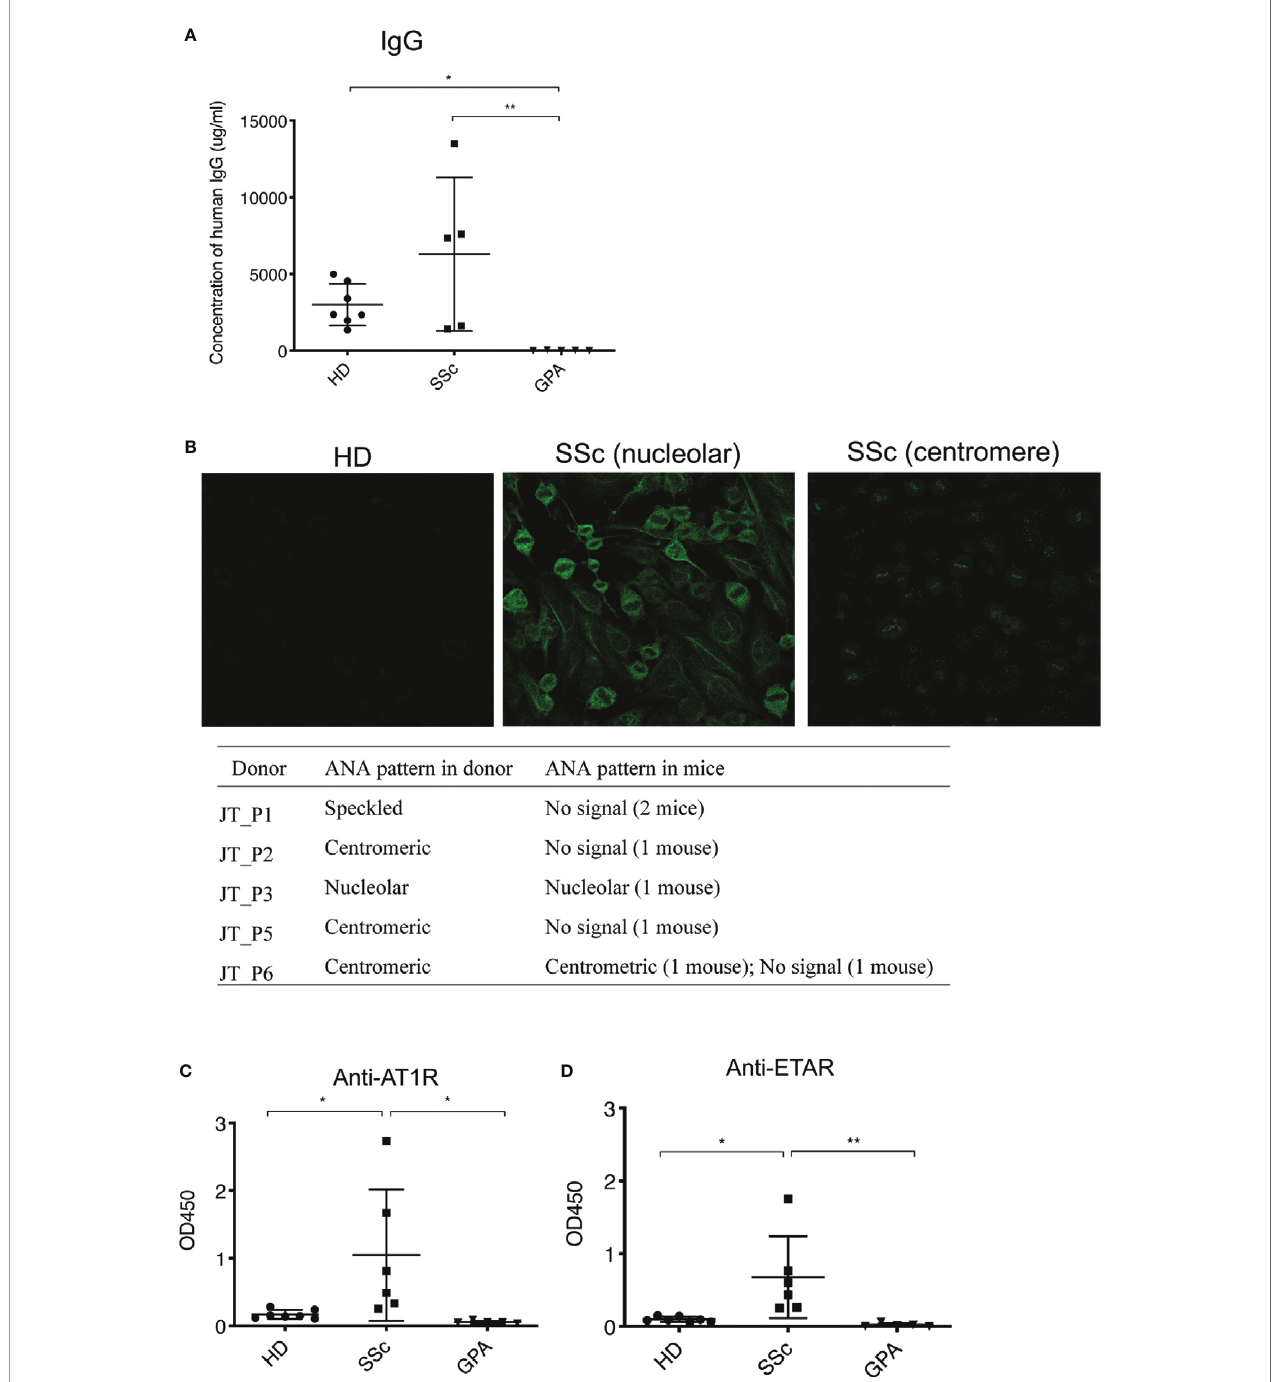
FIGURE 2 | Survival and functionality of human PBMC in recipient mice. (A) Production of total human IgG in sera of recipient mice. The amount of total human IgG was quanti fi ed in a sandwich ELISA using human IgG-speci fi c antibodies for capture and detection. (B) ANA production in sera of recipient mice. The ANA binding patterns of the mice were detected using immuno fl uorescence staining on human HEp-2 cells. (C) Levels of human IgG autoantibodies against AT1R (C) and ETAR (D) in sera of recipient mice. The autoantibodies were detected by ELISA coated with membrane extracts from CHO cells overexpressing hAT1R or hETAR. All data are presented as mean ± SD and statistical analysis was performed using ANOVA (*p < 0.05, **p <